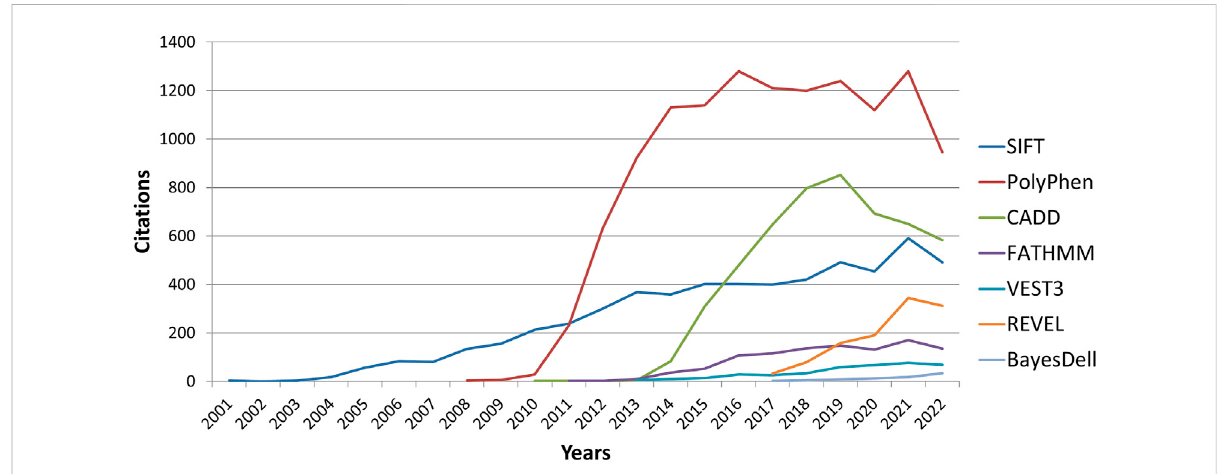
FIGURE 3 Graphicillustratingnewcitationnumberperyear(according toGoogleScholar)ofthetopthreemostcitedtools(PolyPhen-2,SIFT,andCADD) versus the four tools that had frequent outperforming analysis (VEST3, REVEL, FATHMM, and